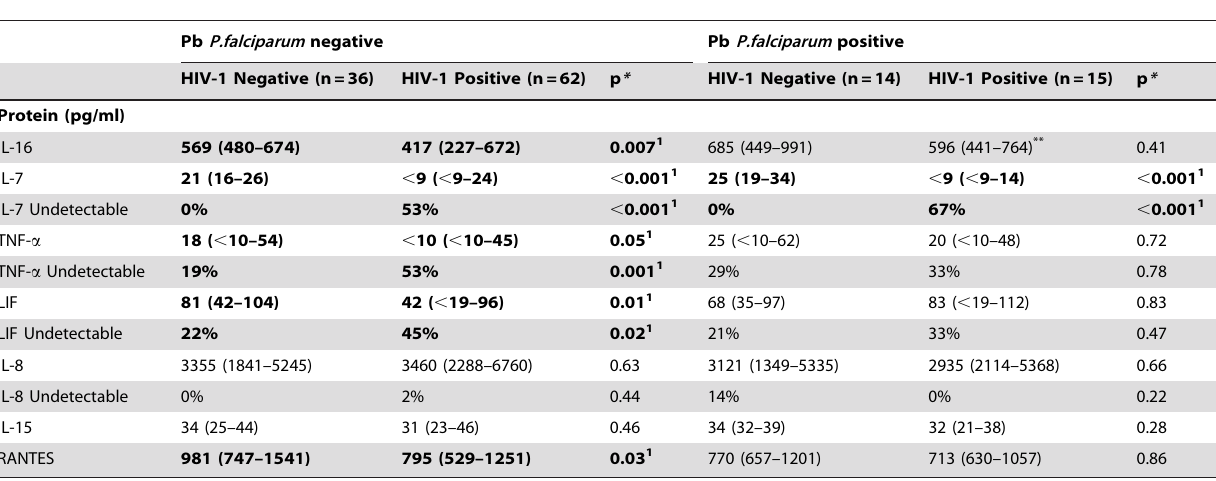
Table 5. Difference in placental cytokine secretion levels (Proteins) between HIV-1 negative and positive women in relation to peripheral blood Plasmodium falciparum status.